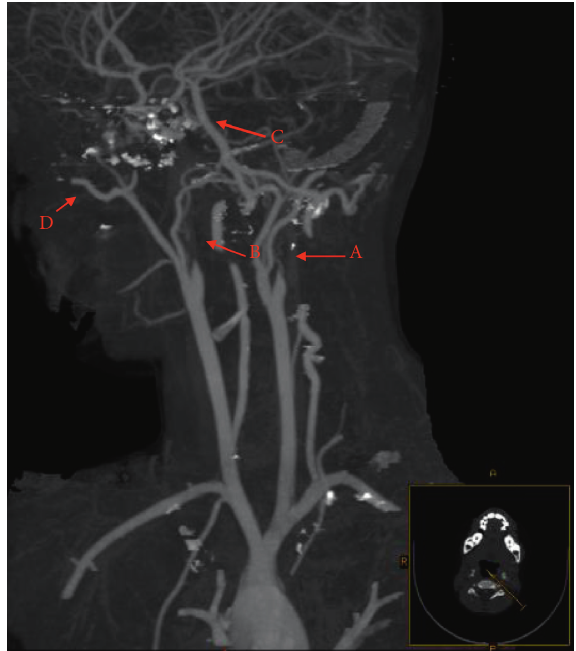
Figure 1: Sagittal view for CT head and neck with arterial phase contrast showed bilateral internal carotid artery (ICA) agenesis as shown by arrows A and B. Arrow C shows collaterals communi- cating with cerebral circulation that was supplied by an enlarged posterior communicating artery (POCMA) from a basilar artery (BA) and arrow D shows carotid rete mirabile from the external carotid artery.